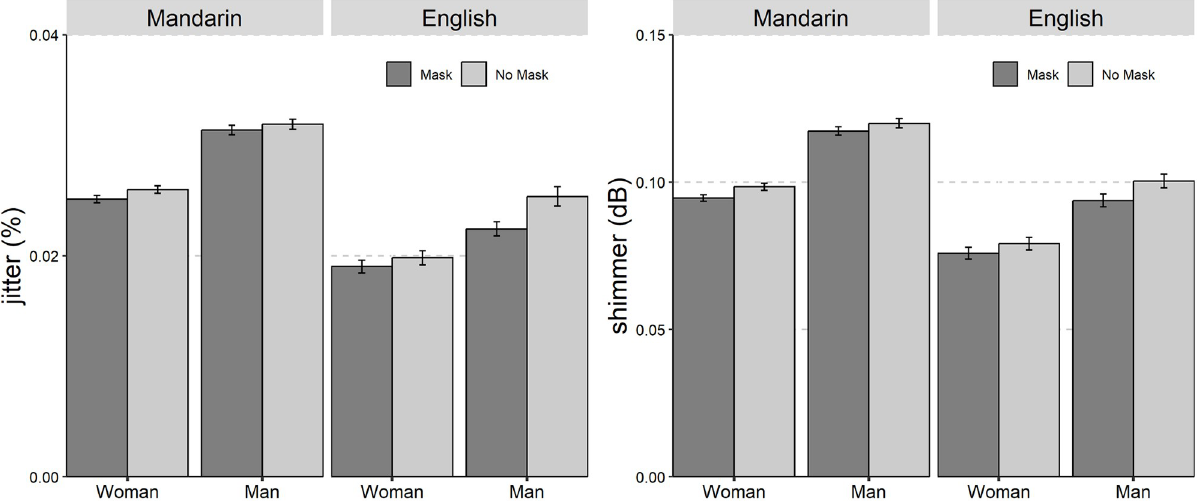
Fig 5. The bar plot (with standard error) of the jitter (in %) and shimmer (in dB) of Mandarin Chinese and English with and without mask across gender (female and male).